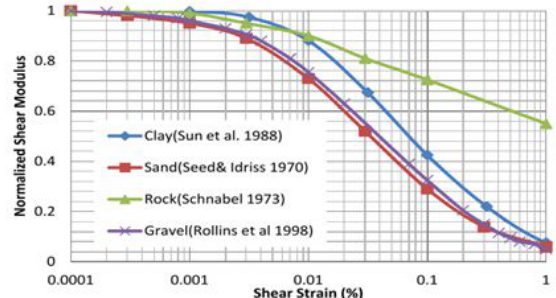
Fig. 4. Relationships between Normalized Shear Modulus and Shear Strain for Rock, Sand Clay and Rock used in Site Response Analysis.